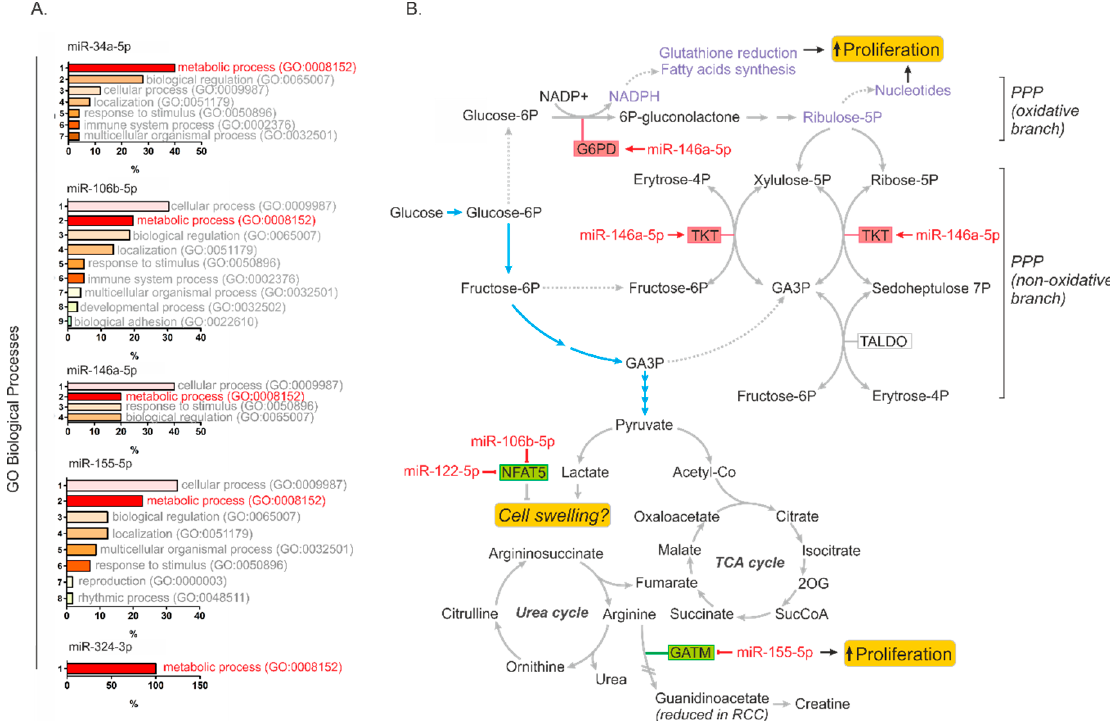
Figure 6. microRNA-mediated regulation of cancer metabolism. ( A ) Functional annotation of genes predicted as targets of microRNAs identified in our study in PanCancer analysis encompassing 14 cancer types and >6000 patients. Only genes for which expression correlated with a given microRNA in at least 10 cancer types were selected for the analysis. The list of genes is provided in Table S7. The plots show results of PANTHER Functional classification analysis according to GO Biological processes annotated to the predicted genes. ( B ) The model showing microRNAs affecting key metabolic pathways in RCC cells: miR-146a-5p upregulates key PPP genes (G6PD and TKT), thereby contributing to enhanced cancer cell proliferation; miR-155-5p suppresses the expressions of gene involved arginine metabolism (GATM); and miR-106b-5p and miR-122-5p may possibly counteract cell swelling induced by enhanced lactate production, by suppressing the expression of NFAT5, which governs the activity of genes encoding proteins transporting osmolytes (e.g., myo -inositol). Abbreviations: GA3P, glyceraldehyde-3-phosphate; 2OG, 2-oxoglutarate. Glycolysis is shown with blue arrows.